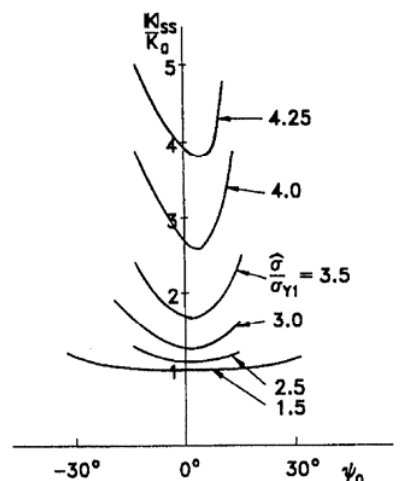
Figure 3: Steady-state interface toughness as a function of the local mixity